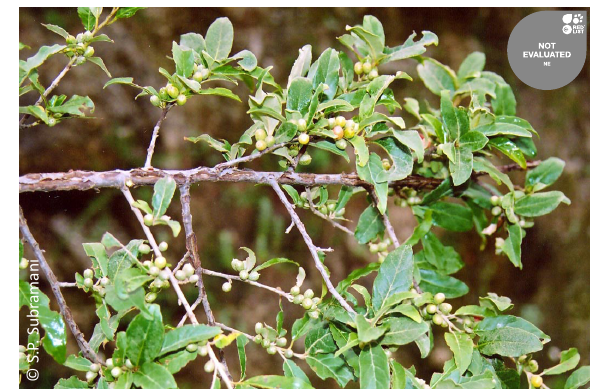
Image 19. Elaeagnus parvifolia Wall. ex